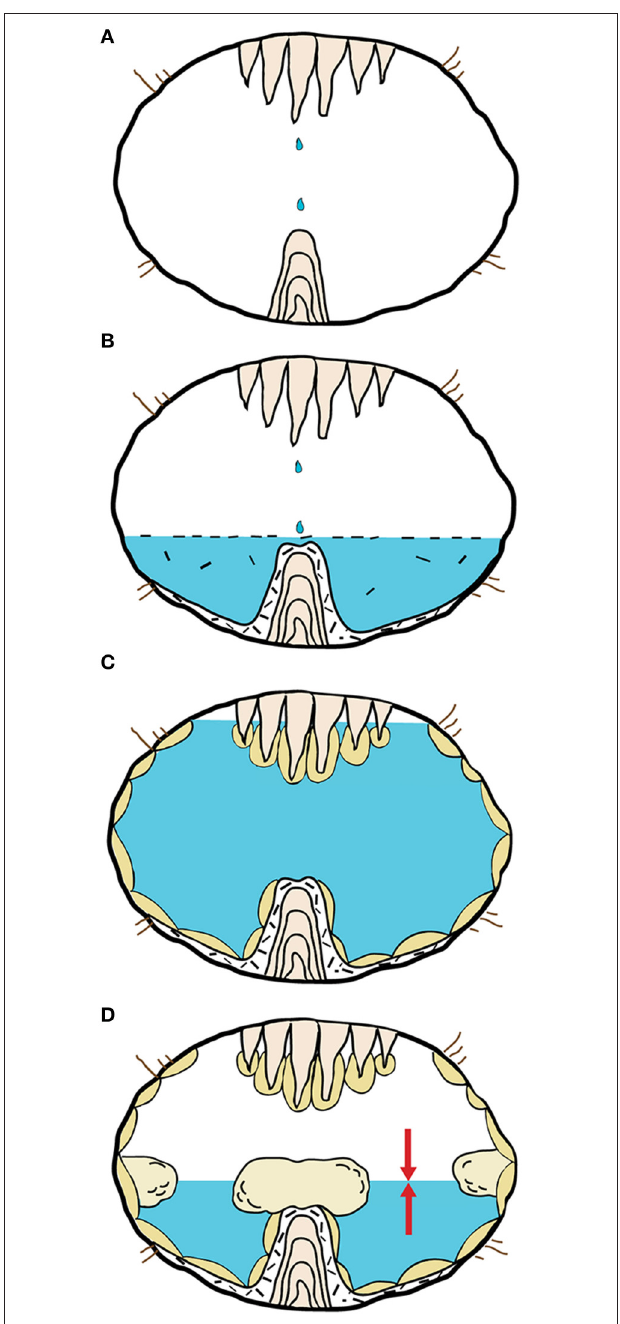
FIGURE 5 | Genesis of the Mushroom speleothem.(A) A stalagmite forms in a subaerial environment. (B) Calcite rafts precipitate at the water table of a cave pool and sink forming a raft cone that surrounds the stalagmite. (C) The raft cone is encrusted by aragonitic cave clouds that form in a subaqueous environment. (D) The mushroom cap forms close to the water table through a microbially-influenced mineralization